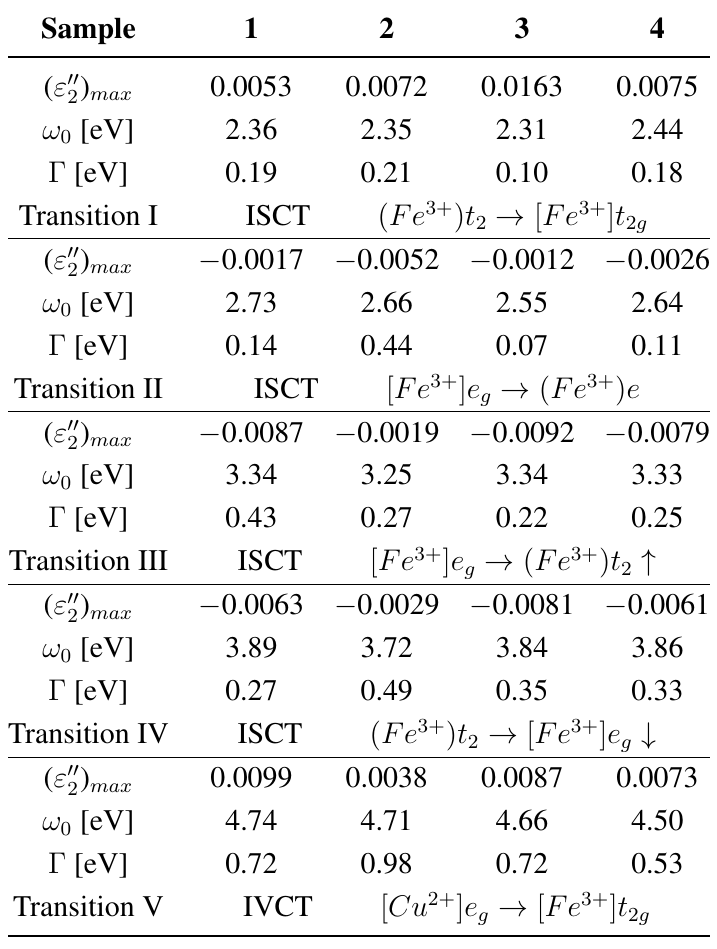
O thin films between 2.0 2 4